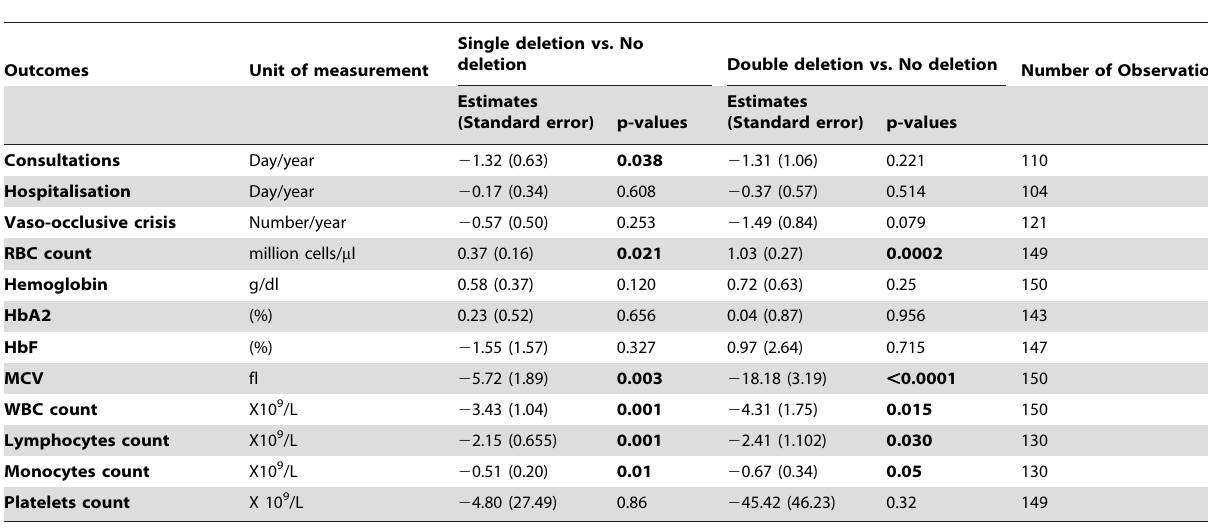
Table 4. Effects of a -thalassemia on key clinical and hematological indices, in generalised linear regression models, adjusted for age, sex and five SNPs* that influence HbF